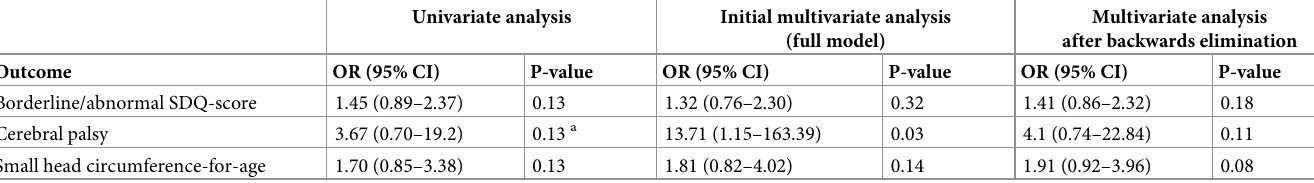
Table 5. Univariate and multivariate analyses for the outcomes SDQ-score, cerebral palsy and head